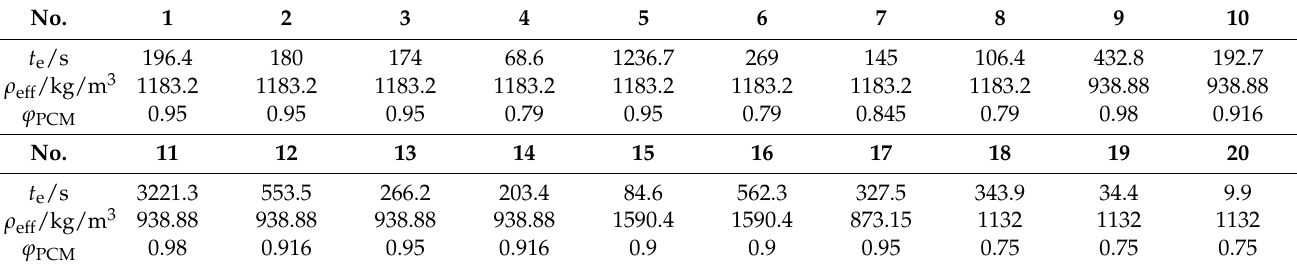
Table 4. Performance indicators of